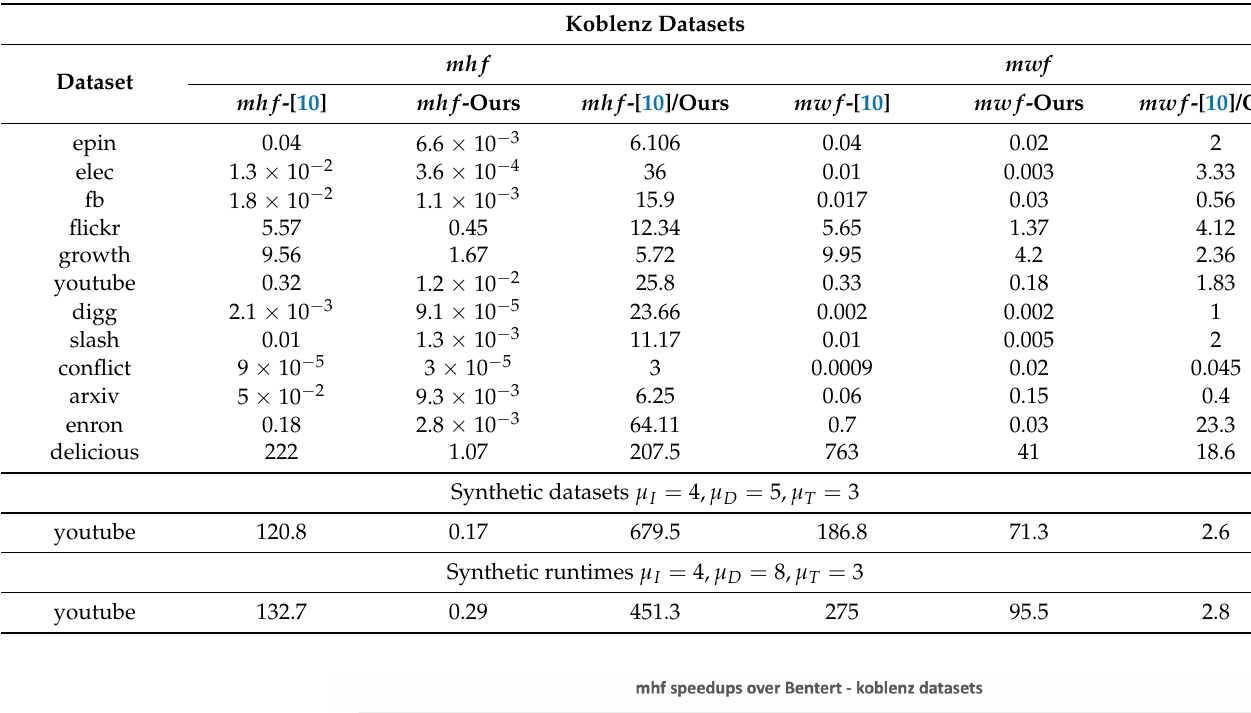
Table 4. Runtimes in seconds.